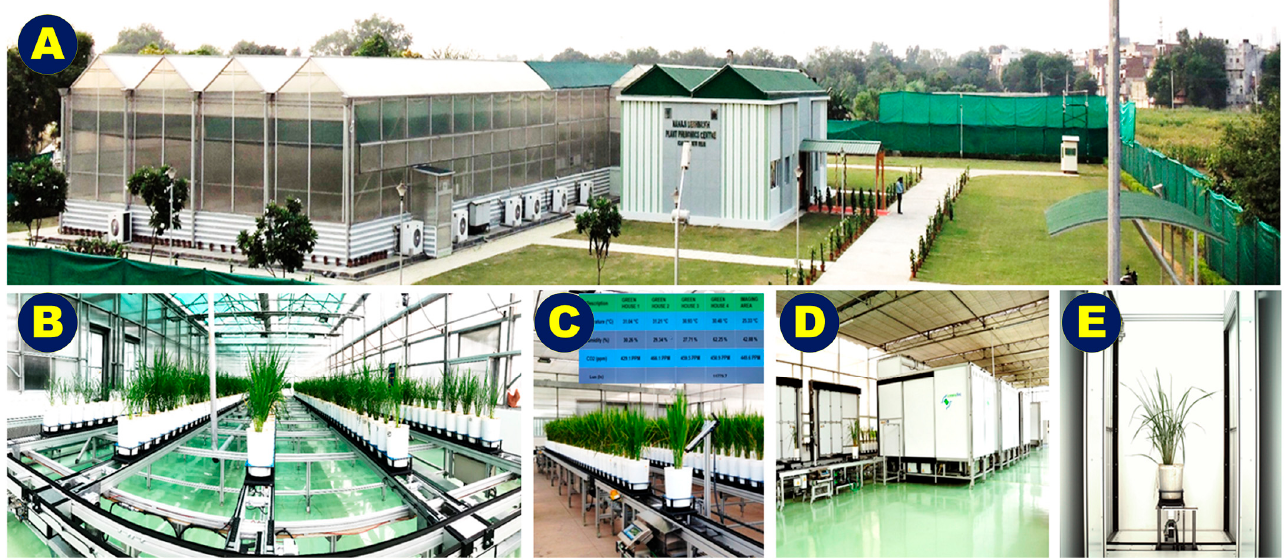
Figure 1. Experimental set up at Nanaji Deshmukh Plant Phenomics Center (NDPPC), ICAR—Indian Agricultural Research Institute, New Delhi, India. ( A ) High-throughput phenotyping (HTP) facility comprises four climate-controlled greenhouses, an imaging area and server room, and an admin block. ( B ) Pot culture experiment in the climate-controlled green-house; ( C ) automatic weighing and watering station; ( D ) imaging area with chambers installed with RGB, IR, and NIR cameras to acquire top- and side-view images. ( E ) RAW images were acquired from a side perspective view at 0 ◦ angle. A total of 990 pots were placed onto an automatic conveyor system installed at four greenhouses, and plants were grown under natural light conditions at the